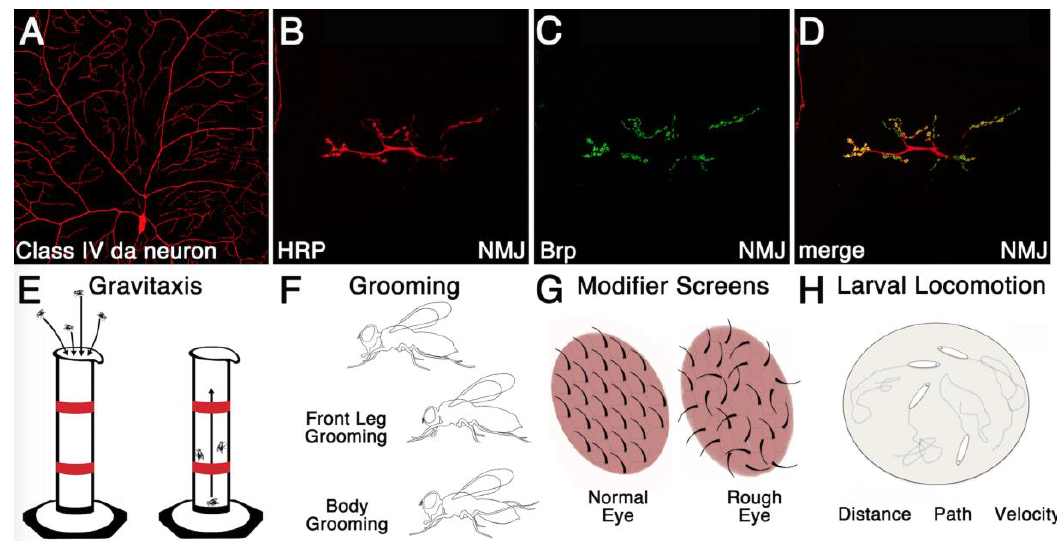
Figure 2. Phenotypic analyses to Assess RBP function within the nervous system. ( A ) Dendrite morphology can be easily assessed using live imaging of the highly complex dendritic trees of Class IV da neurons in larvae. In this image ppkGal4 drives the expression of UAStdtomato to label the da neuron. ( B ) Axon morphology of the larval NMJ can be visualized through the dissection of larvae and subsequent immunofluorescent detection of horse radish peroxidase (HRP) (B) and the active zone marker Bruchpilot (Brp) ( C ) (merge shown in D ). ( E ) Behavior can be investigated using gravitaxis assays, which measure the amount of time it takes for adult flies to walk up to a certain height in a cylinder (the start and stop heights are marked by a red line), after being tapped to the bottom. ( F ) Grooming assays are also used to assess stereotypic repetitive behavior. Drosophila grooming behavior